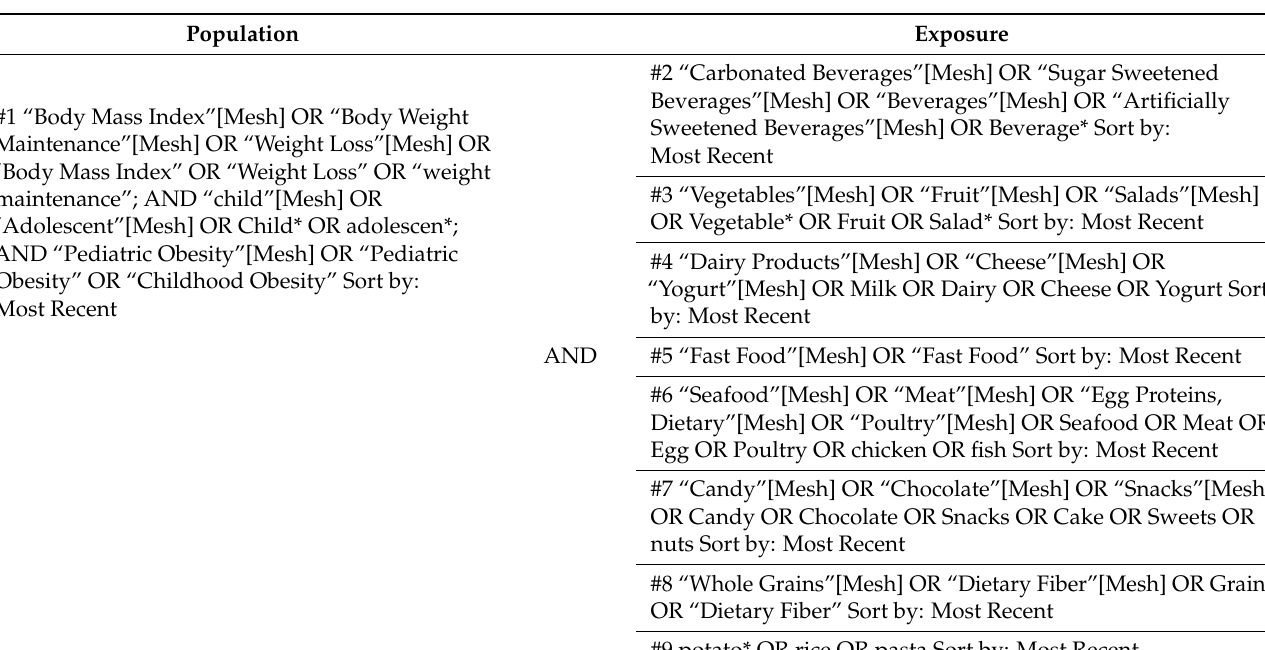
Table 1. Search strategy used in the systematic literature